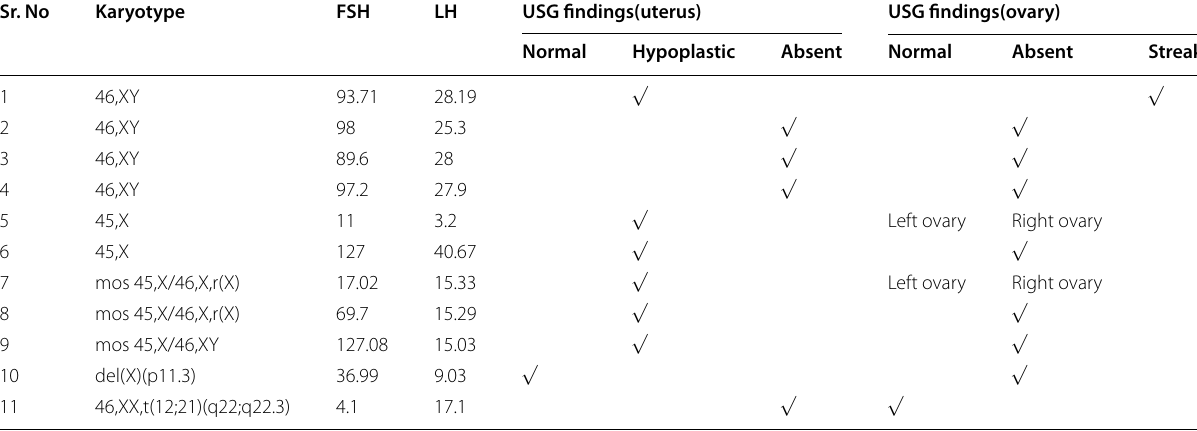
Table 5 Case-wise FSH, LH levels and USG findings in PA according to cytogenetic abnormality Sr.